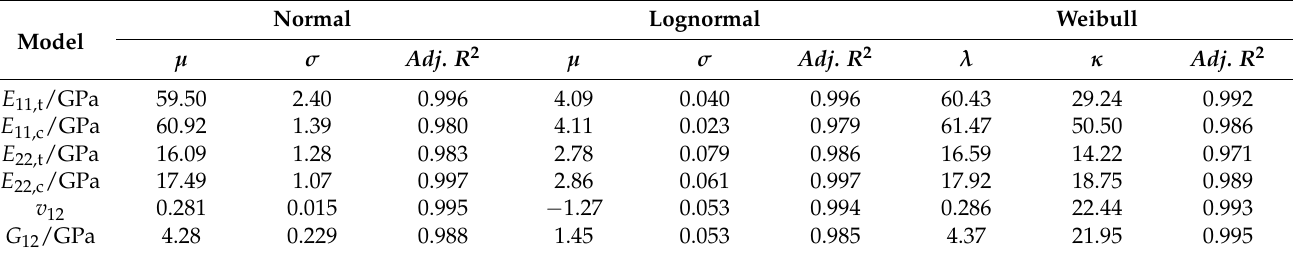
Table 7. Statistical distribution parameters for the stiffness properties of H-GFRPs at